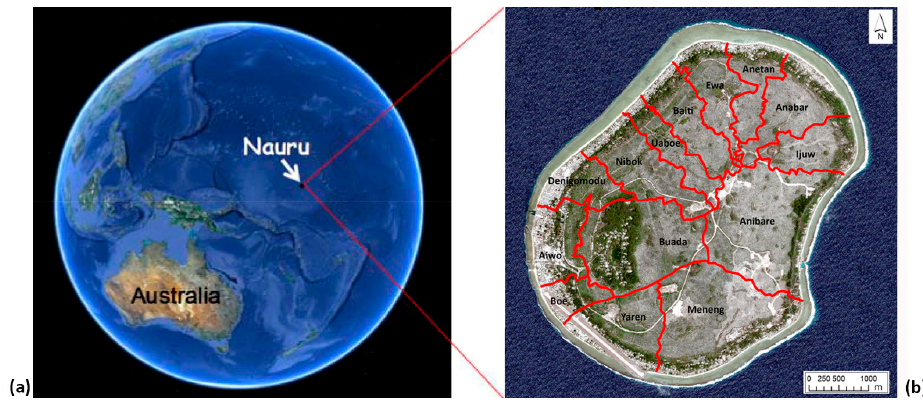
Figure 2. Nauru position at 0°32 ′ S and 166°56 ′ E ( a ); and aerial photo of the island in 2009 with its districts ( b ).